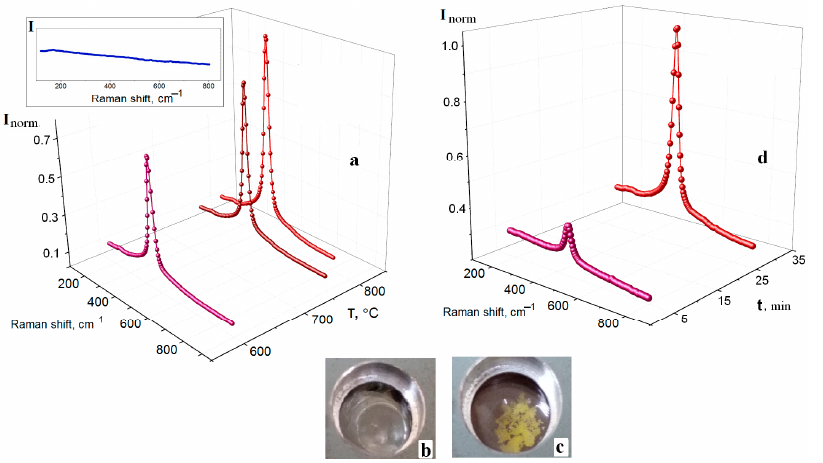
Figure 2. ( a ) Raman spectra of the melt 0.9FLiNaK–0.1CeF 3 (10 min exposure in air atmosphere at a fixed temperature). Inset denotes the Raman spectrum of the FLiNaK melt recorded at 600 °C; ( b ) image of the FLiNaK melt after 40 min exposure at 700 °C in air atmosphere; ( c ) image of the 0.85FliNaK–0.15CeF 3 melt after 90 min exposure at 700 °C in air atmosphere; ( d ) Raman spectra of the 0.85FliNaK–0.15CeF 3 melt recorded at 550 °C and different exposure times in air atmosphere.